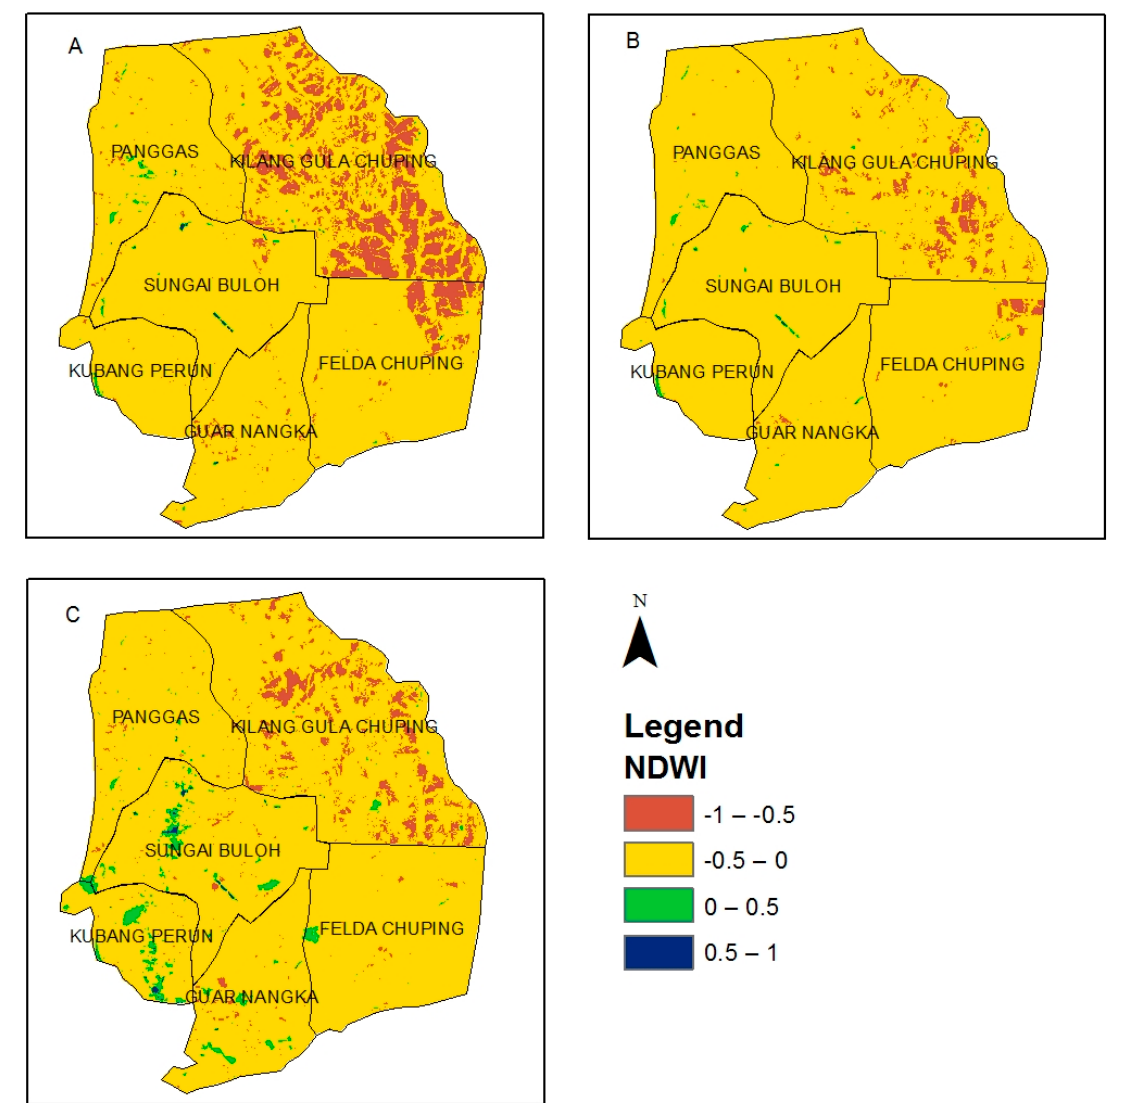
Figure 5. NDWI Map for 2015 ( A ), 2016 ( B ) and 2017 ( C